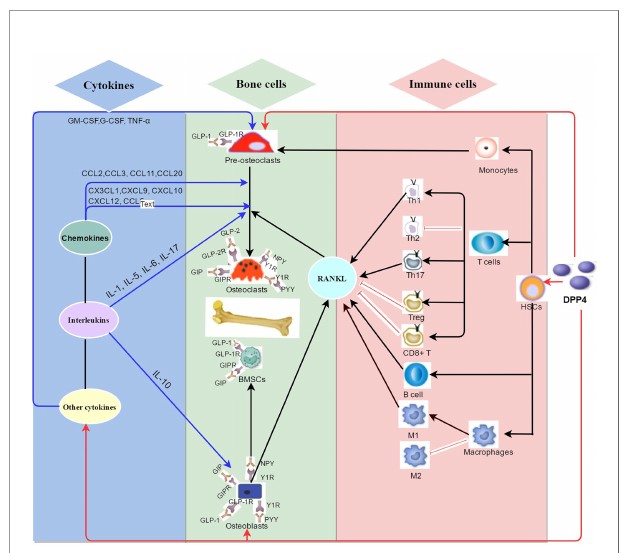
FIGURE 2 | Summary of the potential mechanisms of DPP4 on bone metabolism in bone environment. As a newly discovered adipokine originated from mature adipocytes including bone marrow adipocytes, DPP4 plays a complex role in classical enzyme functions and non-enzyme functions in bone metabolism. (1) (red arrow) DPP4 might indirectly regulate bone remodeling by binding to multiple peptides substrates on bone cells such as glucagon-like peptide-1 (GLP-1), Glucagon-like peptide-2 (GLP-2), and glucose-dependent insulinotropic polypeptide (GIP), neuropeptide Y (NPY) and peptide YY (PYY). (2) (black arrow) DPP4 acts as receptor or costimulatory protein of different immunomodulation signaling process of diversi fi ed immune cells including CD4+ T cells, CD8+ T cells, B cells and macrophages. (3) (blue arrow) DPP4 hydrolyzes different sits on chemokines, interleukins, and other cytokines which take part in bone